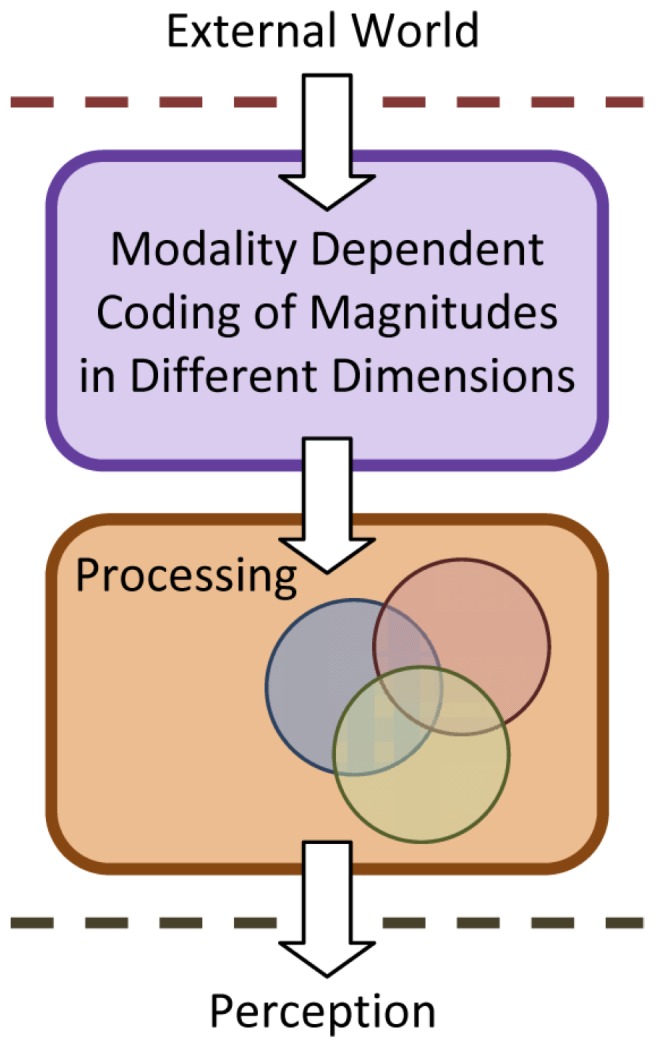
Mechanism of magnitude processing.This image highlights two points: different initial coding of information throughout the modalities and sharing of some brain areas among processing of magnitudes in two or more different dimensions (shown as circles).